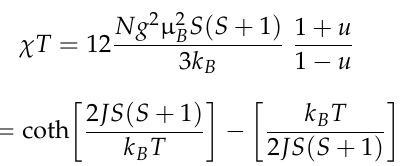
Figure 5. Zfc and fc susceptibility in low temperature range ( a ) and isothermal magnetization curves ( b ).